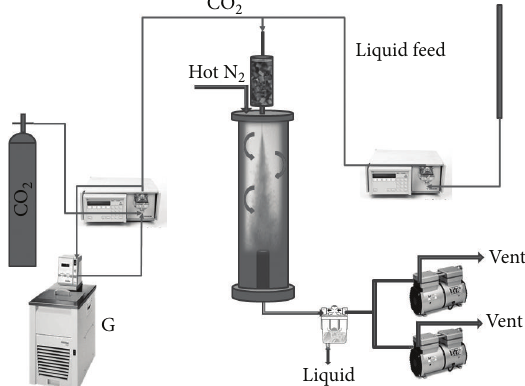
Figure 1: Scheme of SAA plant. G is the cool bath to cold the head of high pressure pump.